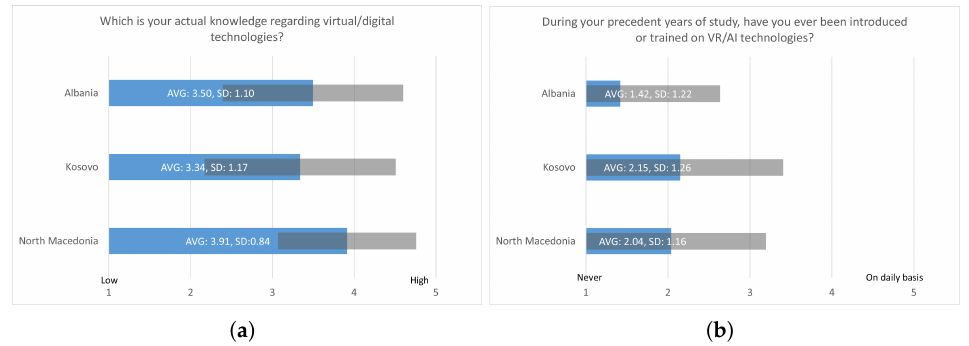
Figure 11. ( a ) Frequency of engagement in digital learning activities. ( b ) Impact of virtual technologies in specific field of